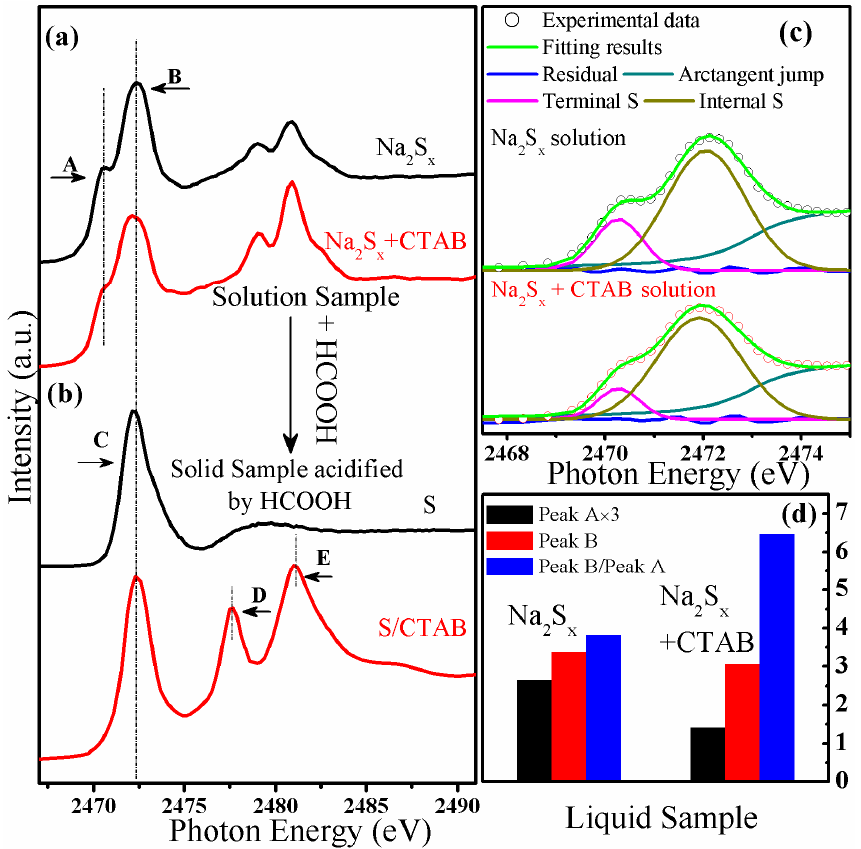
Figure 1. S K-edge X-ray absorption spectroscopy (XAS) data of ( a ) Na 2 S X and Na 2 S X + cetyltrimethylammonium bromide, CH 3 (CH 2 ) 15 N + (CH 3 ) 3 Br − (CTAB) solutions, ( b ) the precipitates collected from the acidified solutions. The fitting of the lower energy region of the spectra of ( a ) is shown in ( c ), while the intensities of peaks A and B and the ratio of Peak B/Peak A are shown in ( d ).